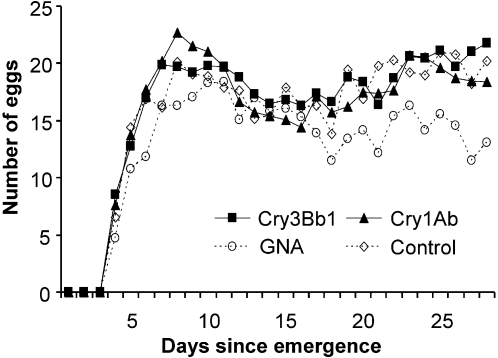
Mean daily fecundity of Chrysoperla carnea fed artificial diet containing insecticidal proteins.Per g dry weight, 150 µg Cry3Bb1, 120 µg Cry1Ab or 9 mg GNA (positive control) were incorporated. Pure diet served as a negative control. N = 33–35.